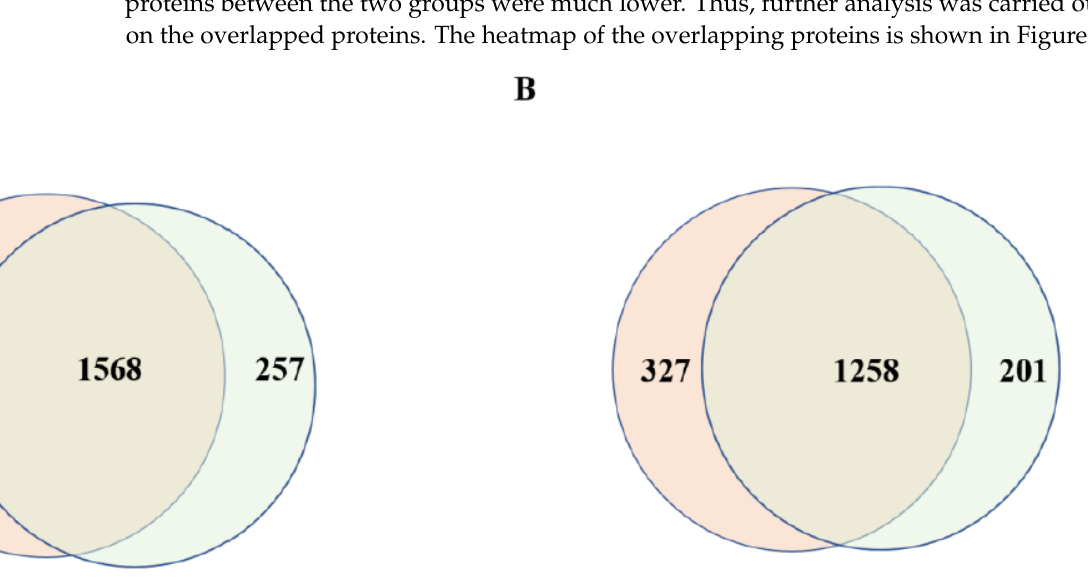
Figure 3. The heatmap of the proteins in placental EVs from missed miscarriage and healthy pregnancy. Figure 2. The number of proteins in placental micro-EVs ( A ) or nano-EVs ( B ) from missed miscarriage and healthy pregnancy.